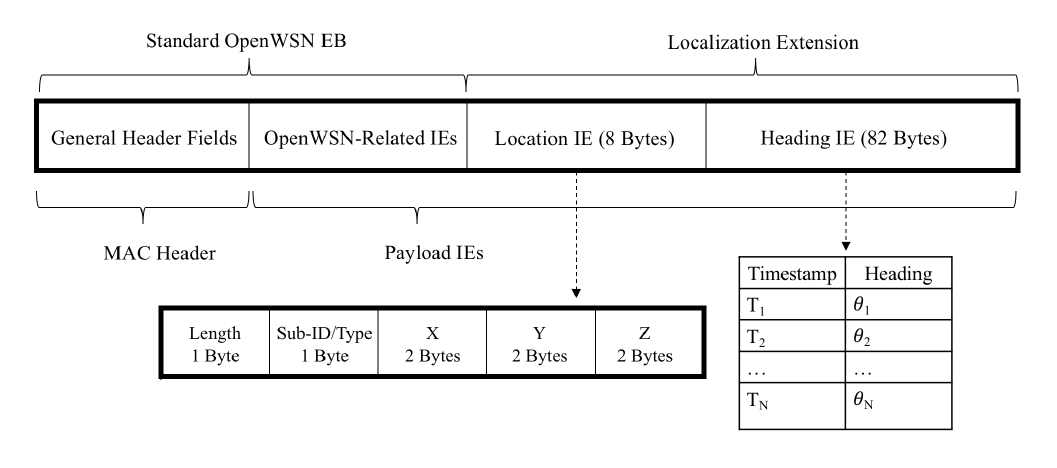
Figure 6. OpenWSN sensor nodes periodically broadcast packets, called enhanced beacons (EBs), which contain network-related data. EBs contain Information Elements (IEs), which are containers used to store specific types of payload. The lighthouse sensor node uses EBs to broadcast time-heading tuples. When a sensor node detects a quadrotor laser sweep pulse with its photodiode, it records the pulse’s timestamp. It then waits until it receives a localization EB. Once a localization EB and laser pulse have been received, the sensor calculates the direction that the quadrotor’s laser was pointing when the laser struck the photodiode, providing the sensor node’s bearing relative to the quadrotor. During the calculation procedure, the sensor node searches the localization EB tuples until it finds a time-heading tuple before and a tuple after the recorded laser pulse time. The sensor node then linearly interpolates between these two points and calculates the heading that corresponds to the laser pulse time (Figure 7).